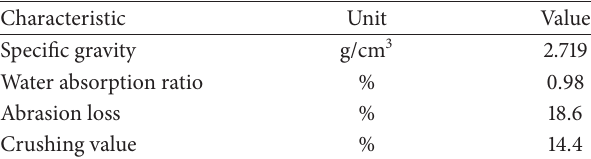
Table 2: Basic properties of basalt aggregate.